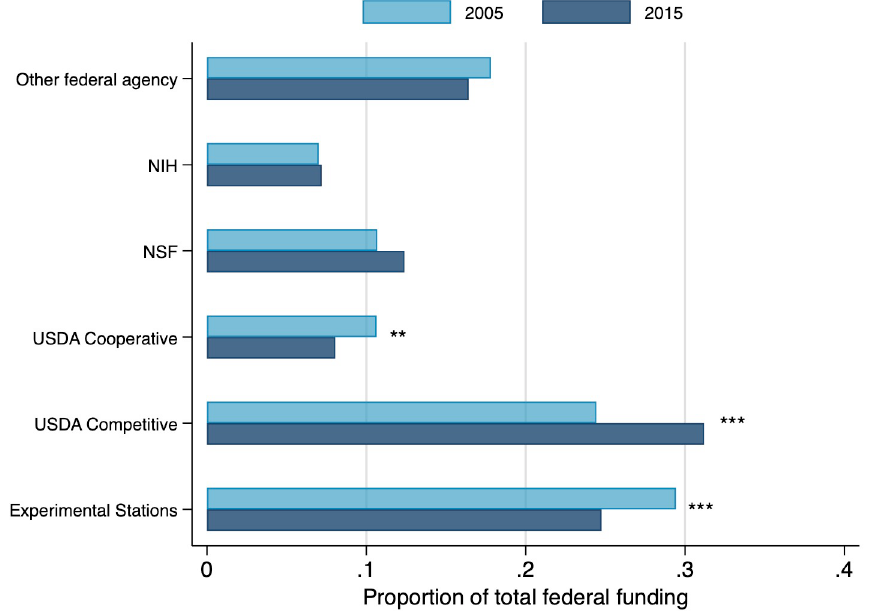
Fig 7. Distribution of federal funding, by type of agency, in 2005 and 2015. Figure displays federal funding by type. Percents are calculated over total federal funding. Federal funds correspond, on average, to 50 percent of total funding. Average total funding—in 2005: $162,896, in 2015: $301,759. Statistical t-tests are showed in the graph. � : 10%, �� : 5%, ��� :1%. N =